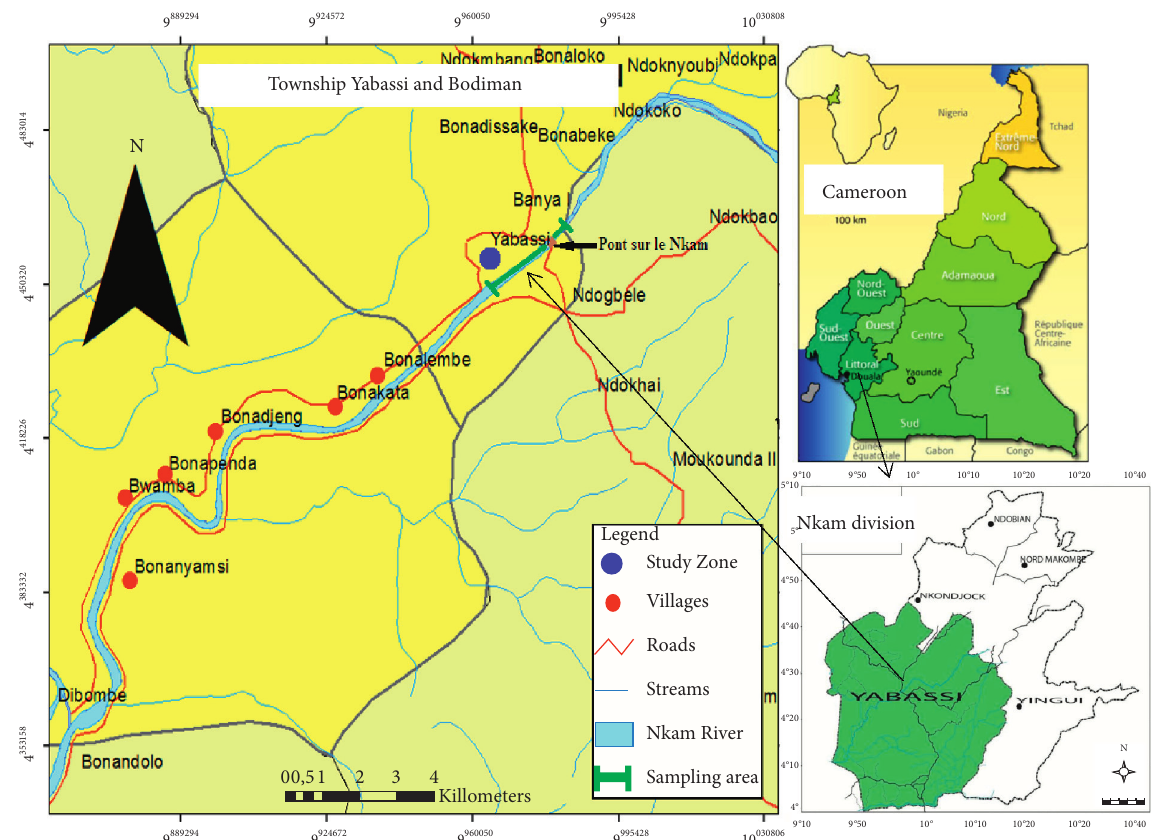
Figure 1: Geographical location of Yabassi. (a) Cameroon, (b) Nkam Department, and (c) Yabassi District (source: adapted from [19]).